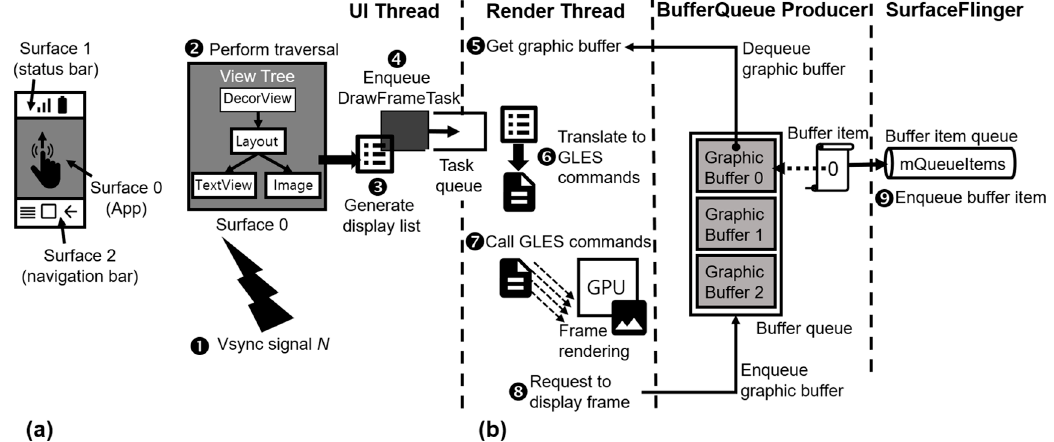
Figure 1. Frame rendering process of the Android graphics pipeline: ( a ) surfaces; ( b ) frame rendering flow.